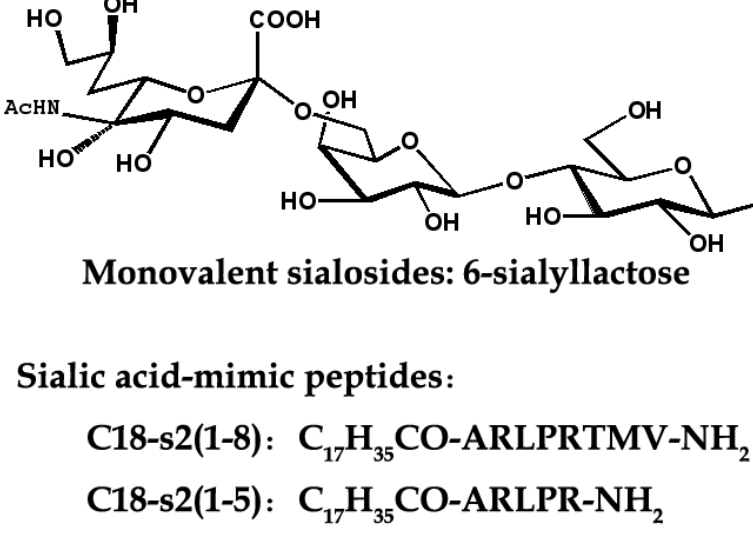
Figure 3. The chemical structures of IAV inhibitors targeting receptor binding sites in